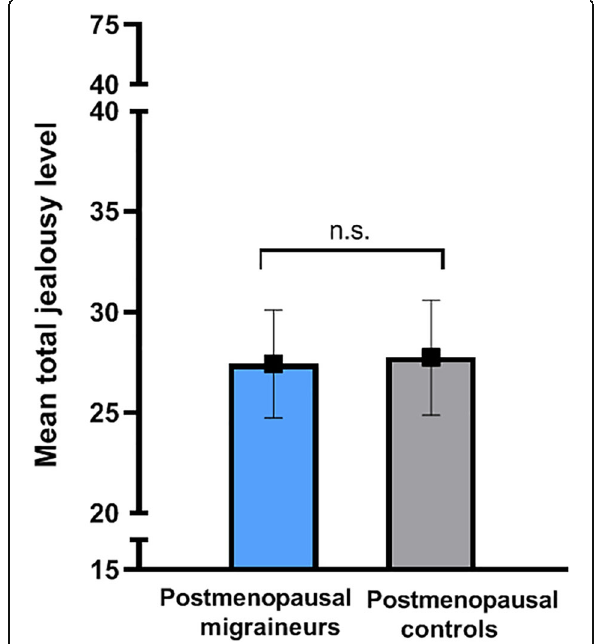
Fig. 3 Mean of total jealousy levels controlled for age and relationship duration. Legend: Postmenopausal women: Postmenopausal migraine patients; Postmenopausal non-migraine controls. Jealousy levels were determined using the validated Buunks Jealousy scale (score between 15 and 75). Depicted levels are mean ± SEM. n.s. = non-statistically significant